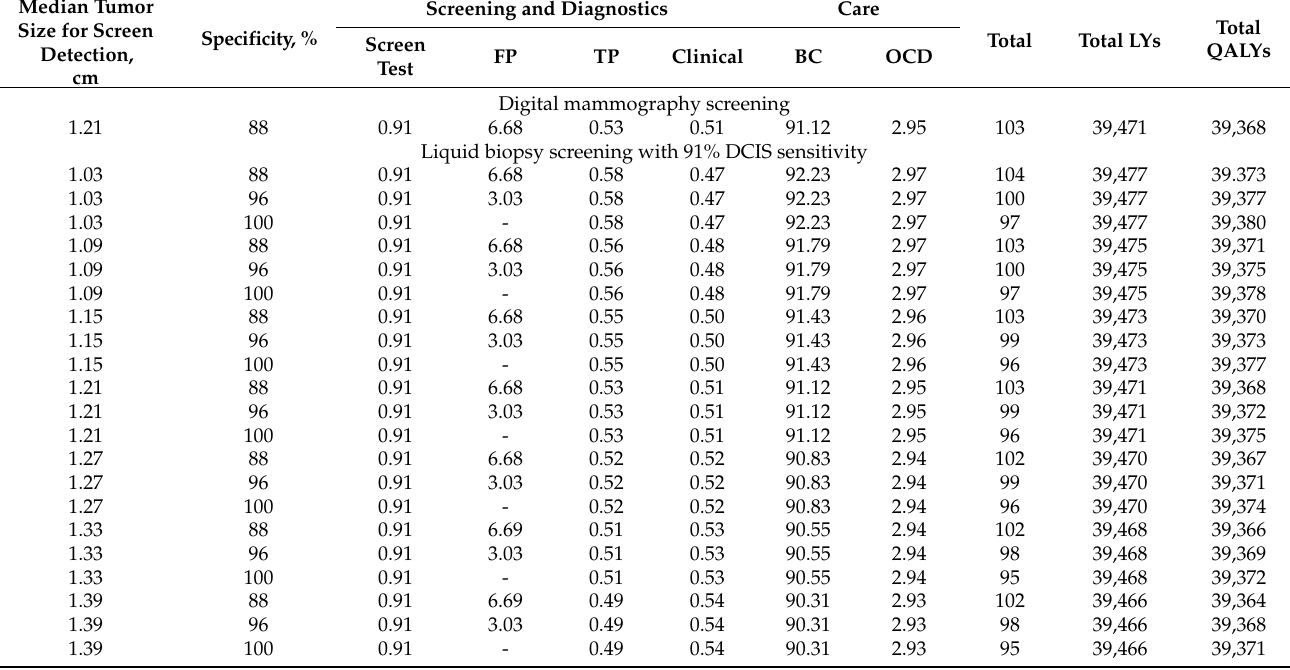
Table A3. QALY decrement of breast cancer screening and care per 1000